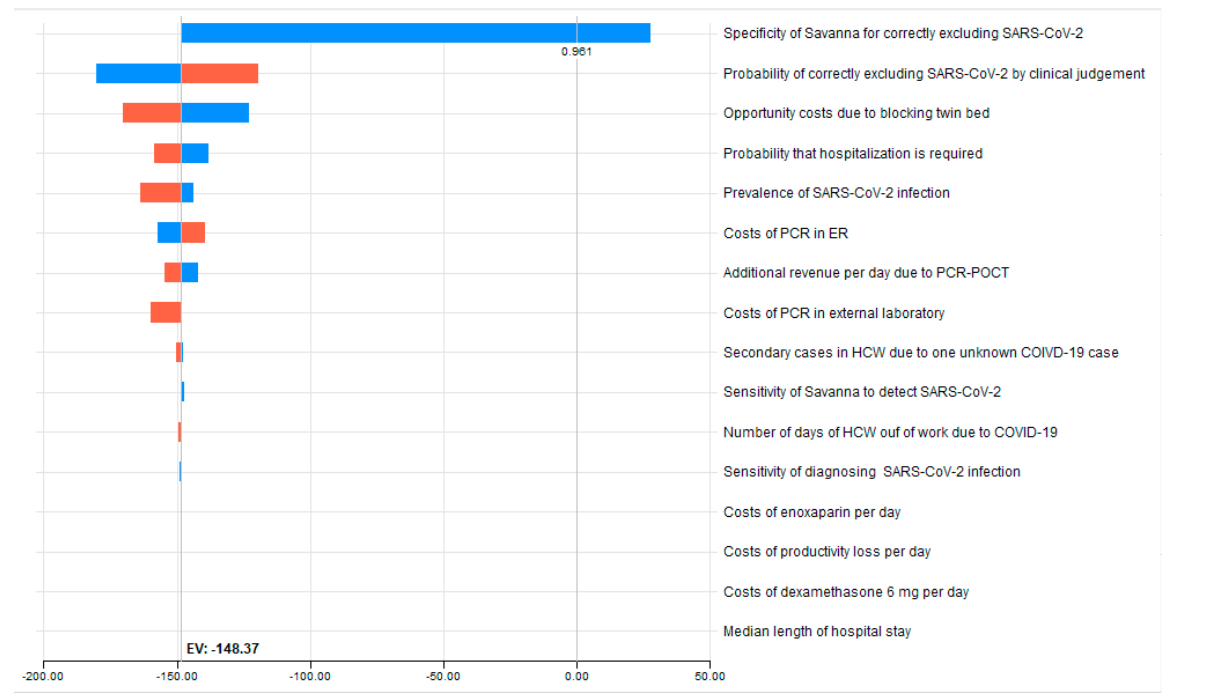
Figure 2. Tornado sensitivity analysis dashboard. The red and blue bars in the Tornado graph represent individual one-way sensitivity analysis performed for each variable. They include a vertical dotted line indicating the expected value (saving of €148.37) by utilizing the Savanna ® . Table 3. Tornado diagram * (Savanna ® PCR-POCT versus the conventional clinical approach).